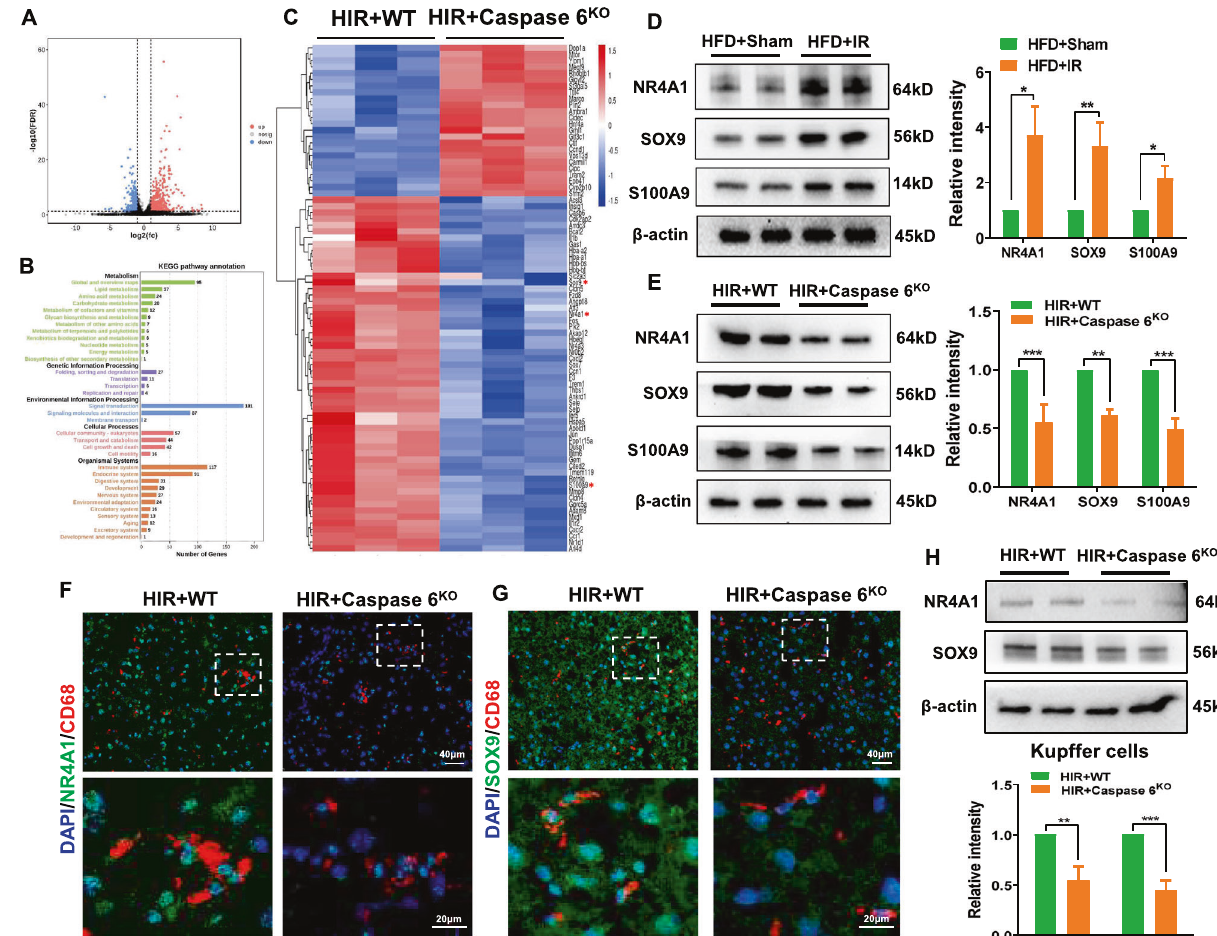
Fig. 3 Caspase 6 activates NR4A1/SOX9 signaling and induces S100A9 expression in IR-stressed fatty liver. WT and Caspase 6 KO mice subjected to fatty liver IR (HIR) were collected to perform RNA-sequencing analysis. A Volcano Plot displaying 615 genes to be upregulated and 440 genes downregulated. B KEGG pathway enrichment analysis of major biological pathways contributing to Caspase 6 function. C Heatmap showing the expression of Top 80 different genes. D , E Western-assisted analysis of NR4A1, SOX9 and S100A9; ( F , G ) IF analysis of AlexaFluor488-labeled NR4A1 or SOX9 and Cy5-labeled CD68 positive macrophages in ischemic livers, Scale bars, 40 µm, 20 µm; ( H ) WB- assisted NR4A1 and SOX9 expression pro fi le in Kupffer cells isolated from mice ischemic fatty livers of WT and Caspase 6 KO mice. N = 4 – 7/ group, all data represent the mean ± SD, * p < 0.05, ** p < 0.01, *** p <